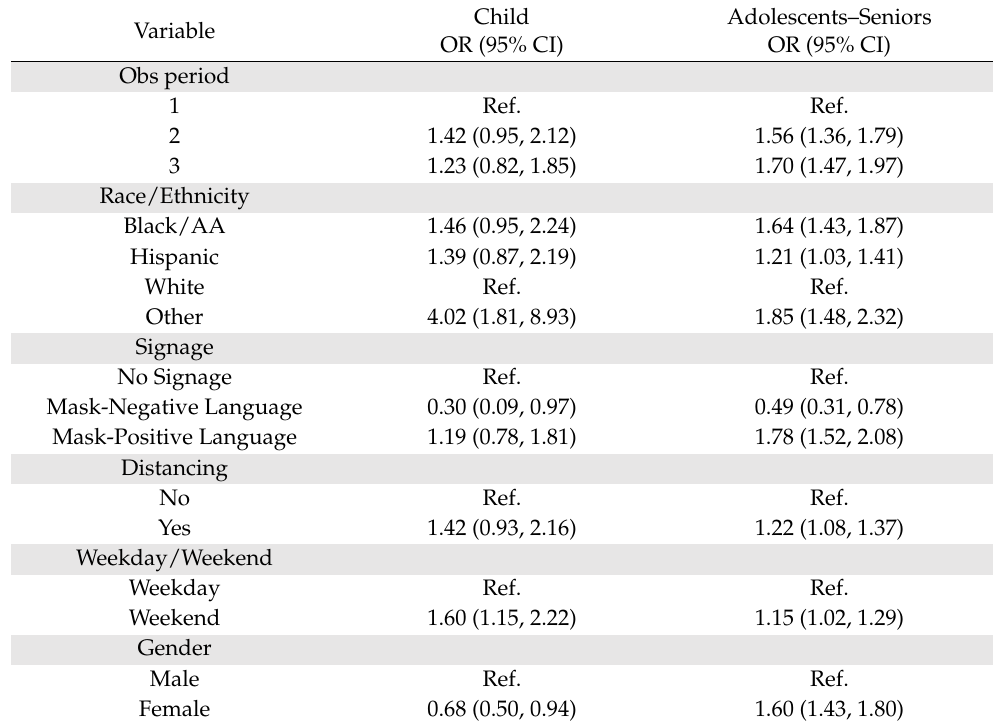
Table 3. Adjusted Odds ratios for full masking, stratified by age group.